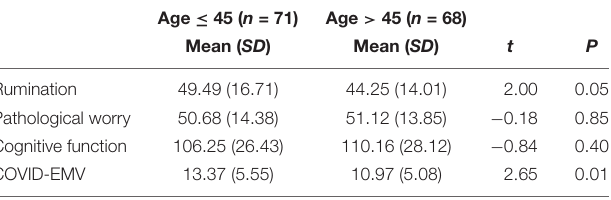
TABLE 2 | t -test results in comparing the age groups a .